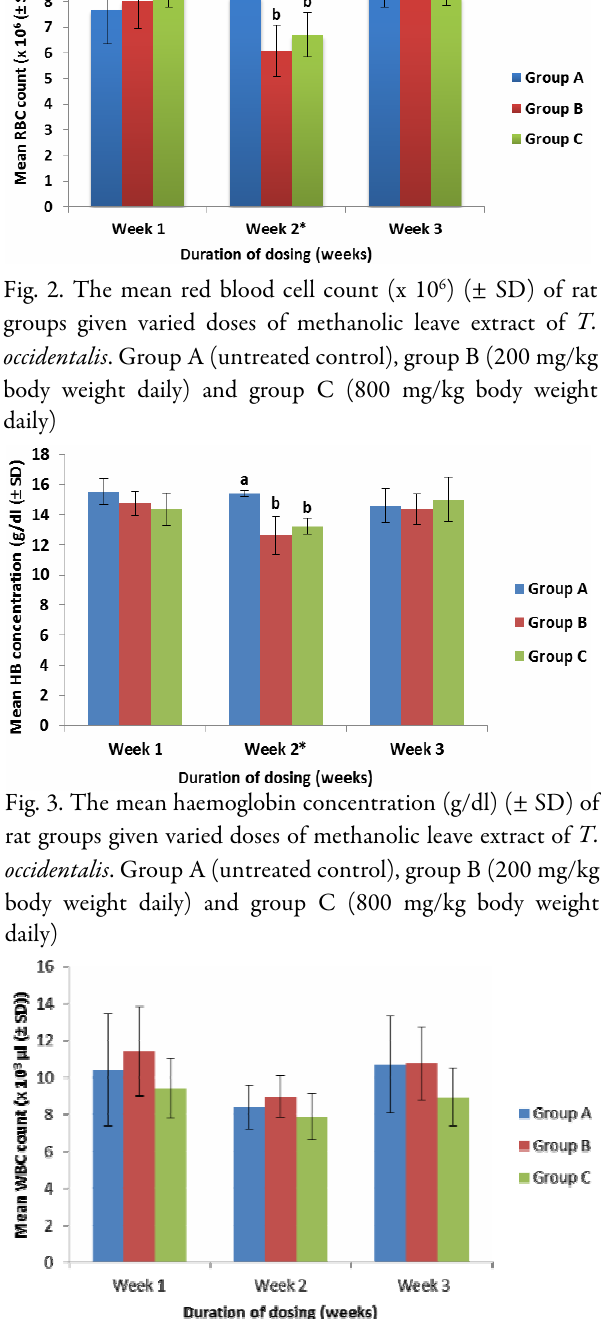
Fig. 4. The mean total white blood cell count (x 10 3 µl) (± SD) of rat groups given varied doses of methanolic leave extract of T. occidentalis . Group A (untreated control), group B (200 mg/kg body weight daily) and group C (800 mg/kg body weight